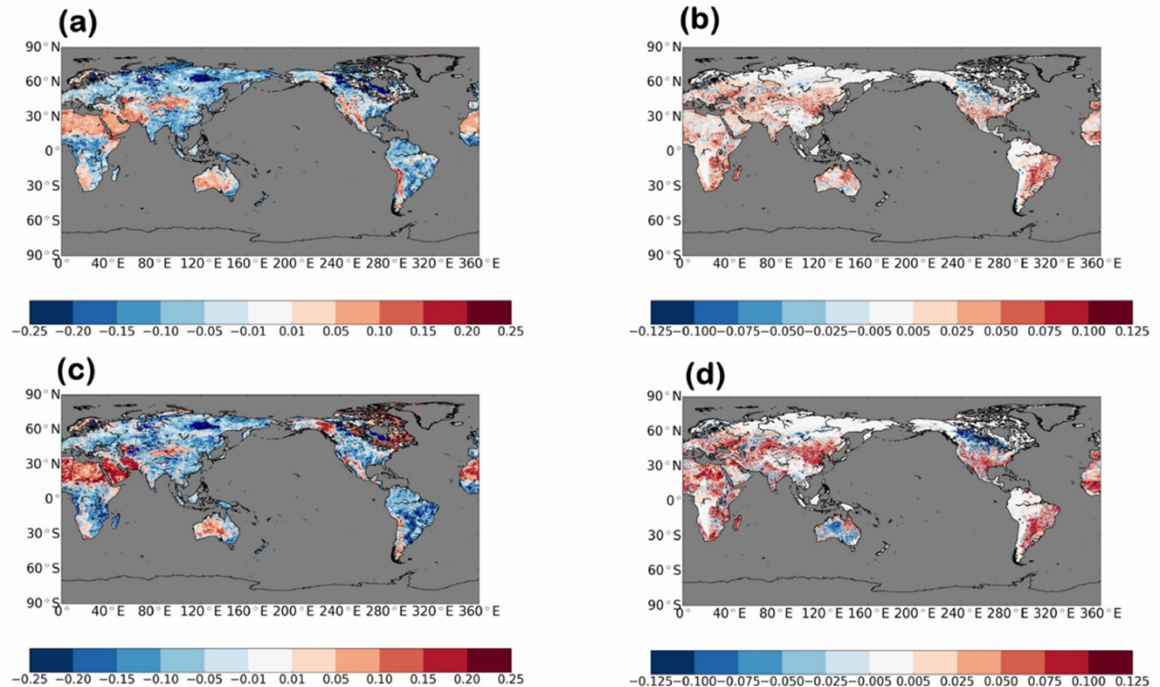
Figure 5. Biases in the CTL against ERA5 and EXP minus the CTL difference of the volumetric soil moisture for ( a , b ) the first soil layer and ( c , d ) the third soil layer from 15 Jun 2019 to 10 August